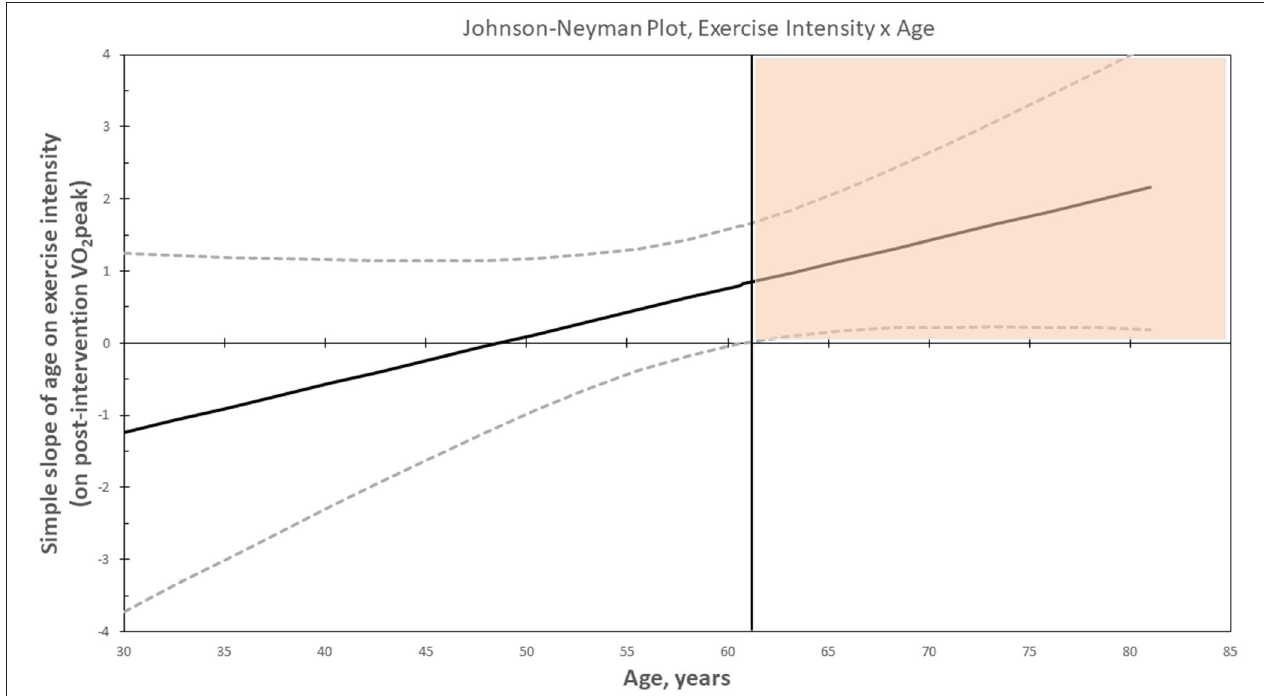
FIGURE 2 | Johnson–Neyman plot showing the simple slope (with the 95% confidence intervals) of age on exercise intensity on post-intervention VO 2 peak. Colored area represents the region of significance ( p <